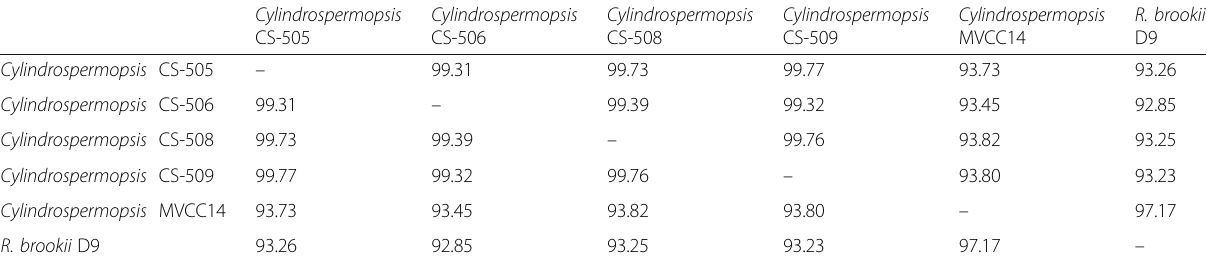
Table 6 Average nucleotide identity (ANI) values for the sequenced C. raciborskii and Raphidiopsis brookii